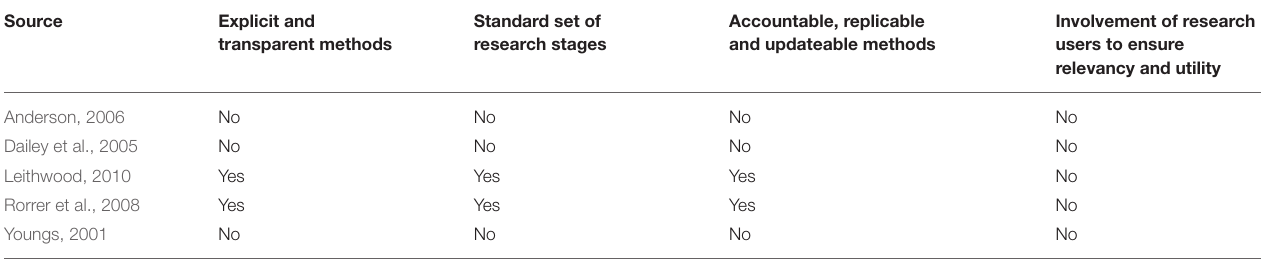
TABLE 3 | Evaluation of conceptual reviews (based on Hallinger, 2013).